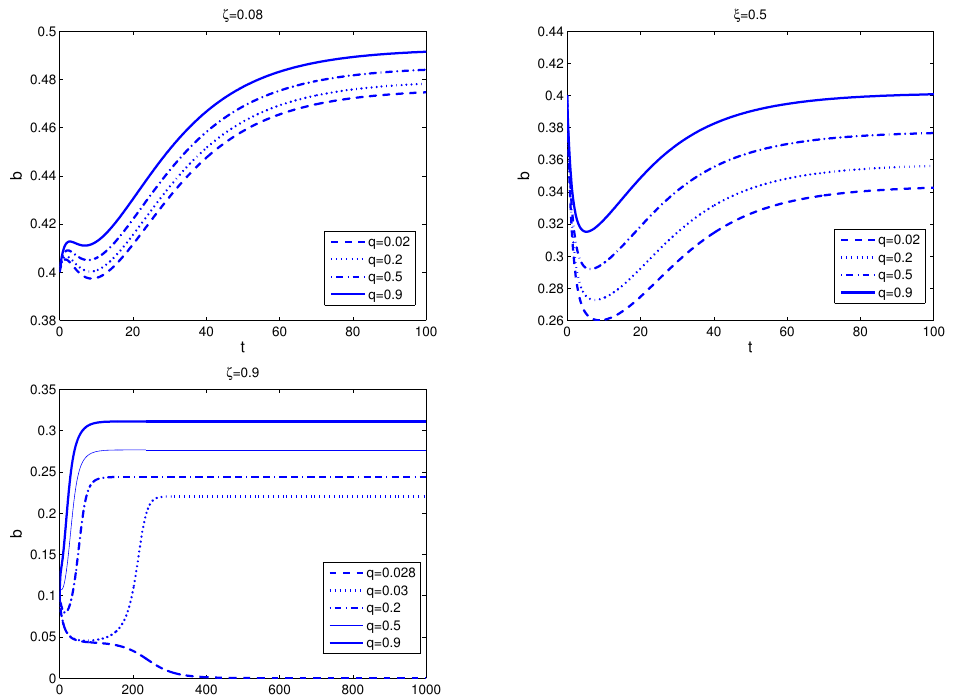
Figure 5. Impact of the customer satisfaction parameter q on the referral campaign in the bistability region, σ ∈ [ σ c , σ SN ] , for different levels of self-information. Initial conditions are chosen in the neigh- bouring of the campaign-standing equilibrium. The other parameters are as in Figure 1. ( Top-left ) Low level of the self-information parameter, i.e., ζ = 0.08 ( k = 2; γ = 0.04) and σ = 0.4. ( Top-right ) Intermediate level of the self-information parameter, i.e., ζ = 0.5 ( k = 2; γ = 0.25) and σ = 0.7. ( Bottom ) High level of the self-information parameter, i.e., ζ = 0.9 ( k = 2; γ = 0.45) and σ =